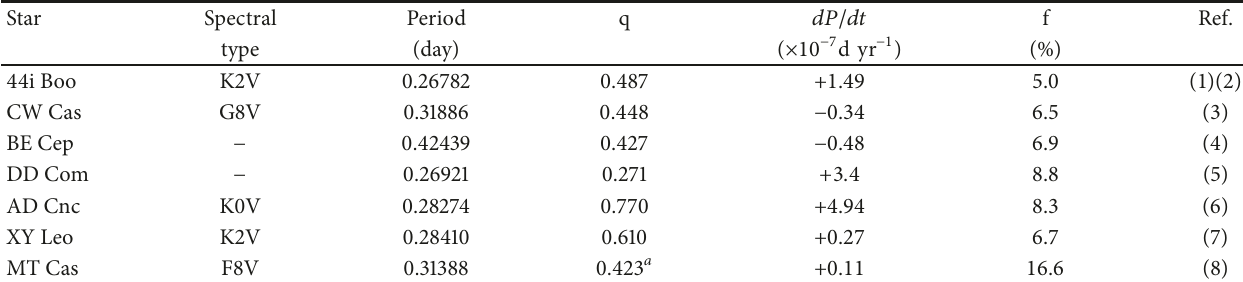
Table 5: Several weak-contact binaries with secular period increasing.